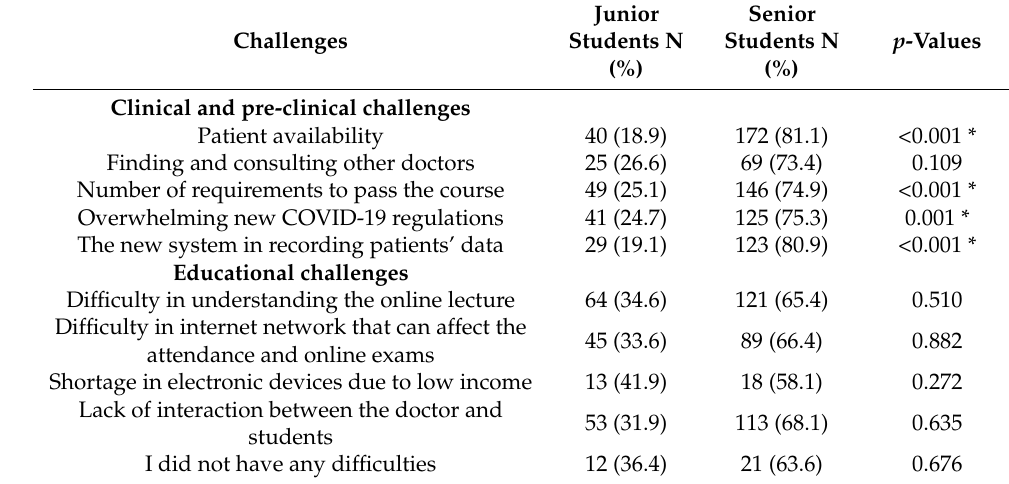
Figure 1. Showing the challenges faced by dental students (in number and percentages) during the COVID-19 pandemic. Table 2. Differences in challenges faced by junior and senior/clinical dental